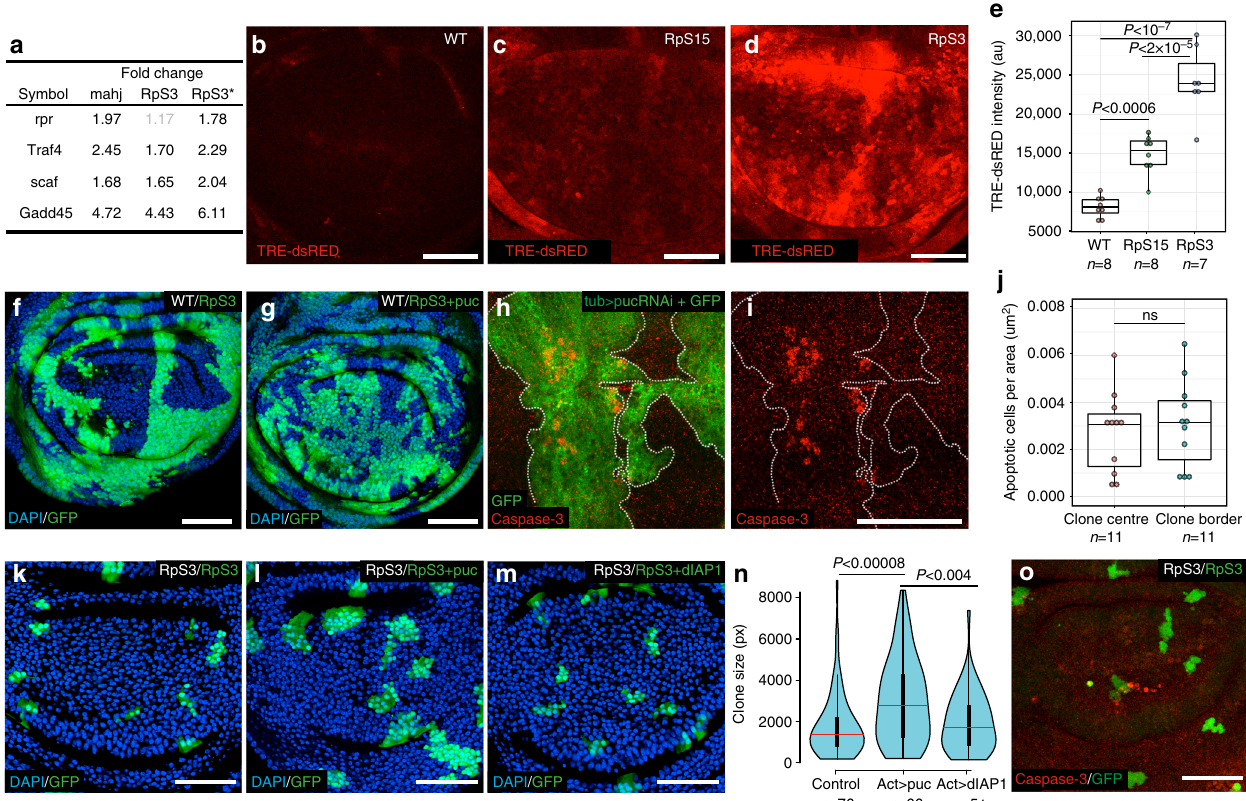
Fig. 2 JNK pathway activity restricts the growth of prospective loser cells. a List of known JNK targets or regulators differentially expressed in the indicated genotypes (fold changes with false discovery rate > 0.1 are in grey ). b – d Activation of the transcriptional reporter of JNK activity (TRE16-dsRED, red ) in WT ( b ), RpS15 + / − ( c ) or RpS3 + / − wing discs ( d ). e Quanti fi cation of fl uorescence intensity from images as in b – d for the indicated genotypes, each dot represents a single wing disc. P values according to a post-hoc Tukey test. For all box and whisker plots the horizontal line represents the median and the upper/lower whiskers indicate the lowest/highest point within 1.5*interquartile range of the lower/higher quartile, respectively. f , g Wing disc harbouring 72-hour-old GFP-negative WT clones within GFP-positive RpS3 + / − tissue with ( g ) or without ( f ) overexpression of puc only in the RpS3 + / − cells (achieved using upd3 -Gal4 to drive expression speci fi cally in loser RpS3 + / − cells). h , i Wing disc with clonal knockdown of puc (tub > puc-RNAi) and GFP expression ( green ) stained with anti-cleaved caspase-3, ( red ), clonal boundaries are indicated by a dotted line . j Quanti fi cation of the density of apoptotic cells in the centre of the clone or at the clonal boundary (i.e. within a 2-cell diameter of the clone periphery) for discs of the same genotype as in h ; each dot represents a single wing disc. k – m RpS3 + / − wing discs harbouring clones overexpressing GFP alone ( k ) or with the addition of puc ( l ) or dIAP1 ( m ). n Size distributions (in pixels) of clones of the same genotypes as in k , m , P values according to a post-hoc Tukey test. o RpS3 + / − wing disc harbouring GFP-overexpressing clones (same genotype as in k ) stained with anti-cleaved caspase-3. Detailed genotypes for each fi gure panel are listed in Supplementary Table 1. Scale bars, 50 μ m throughout all fi